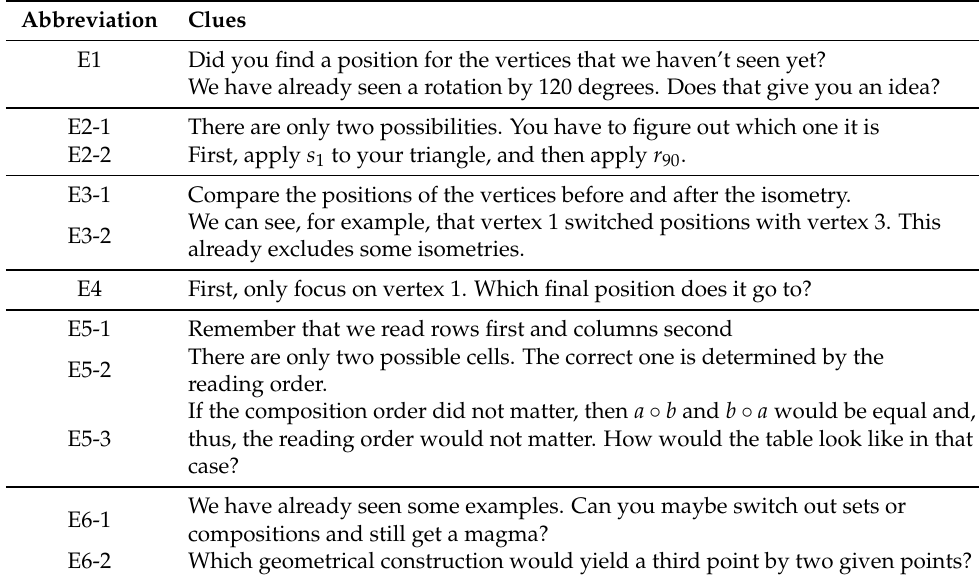
Table A7. Overview of all clues prepared for each task in the key ideas application